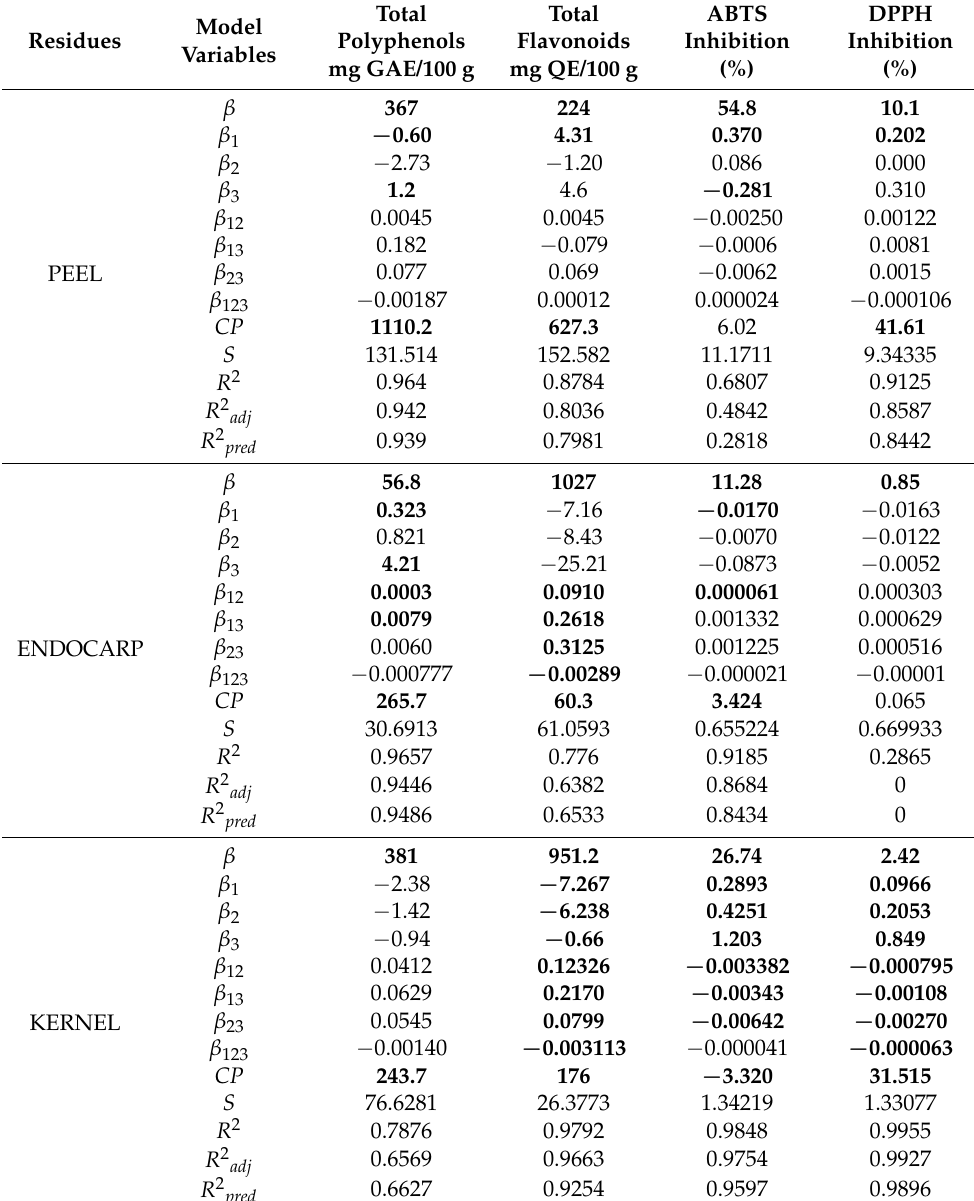
Table 2. Uncoded coefficients, level of significance and goodness-of-fit statistic. Parameters for fitted